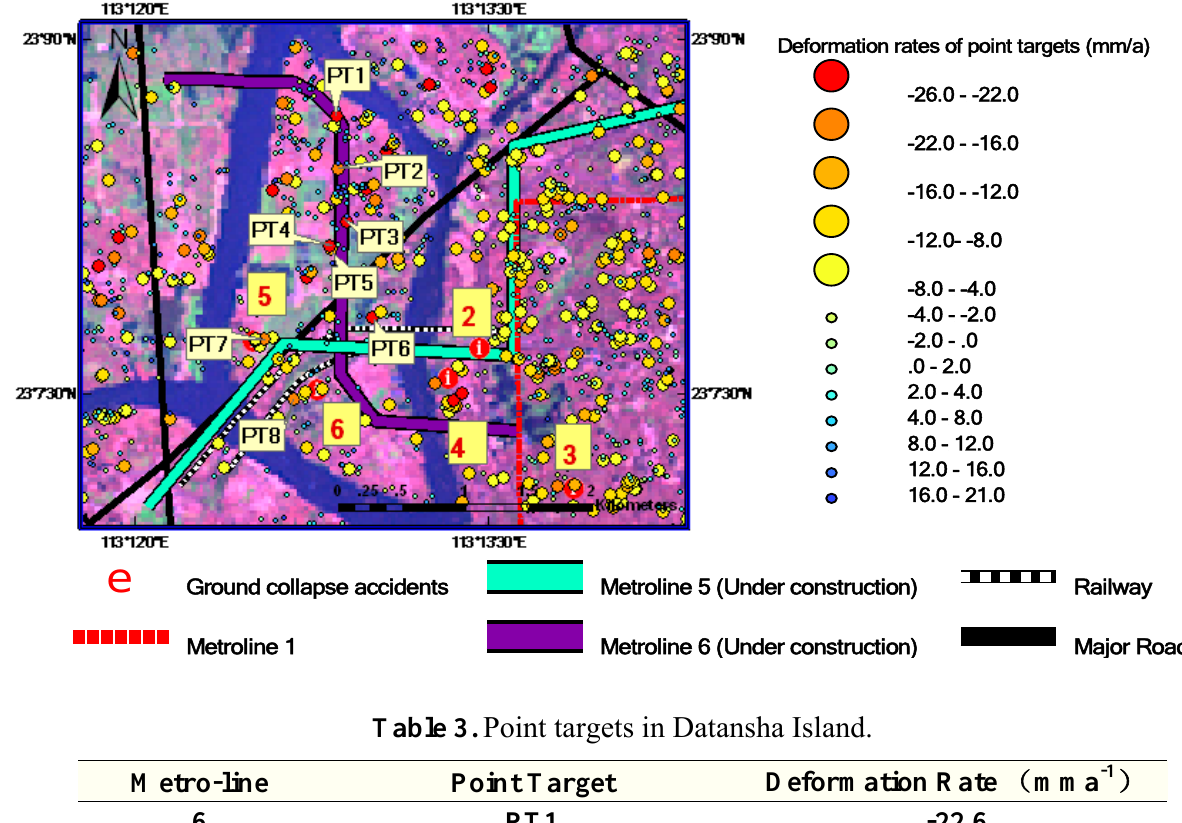
Figure 6. An ASAR-derived ground deformation map in Datansha Island area. PT1–PT8 are test sites along metro-lines 5 and 6. Numbers 2–6 are sites of ground collapse accidents occurred in 2007–2008.